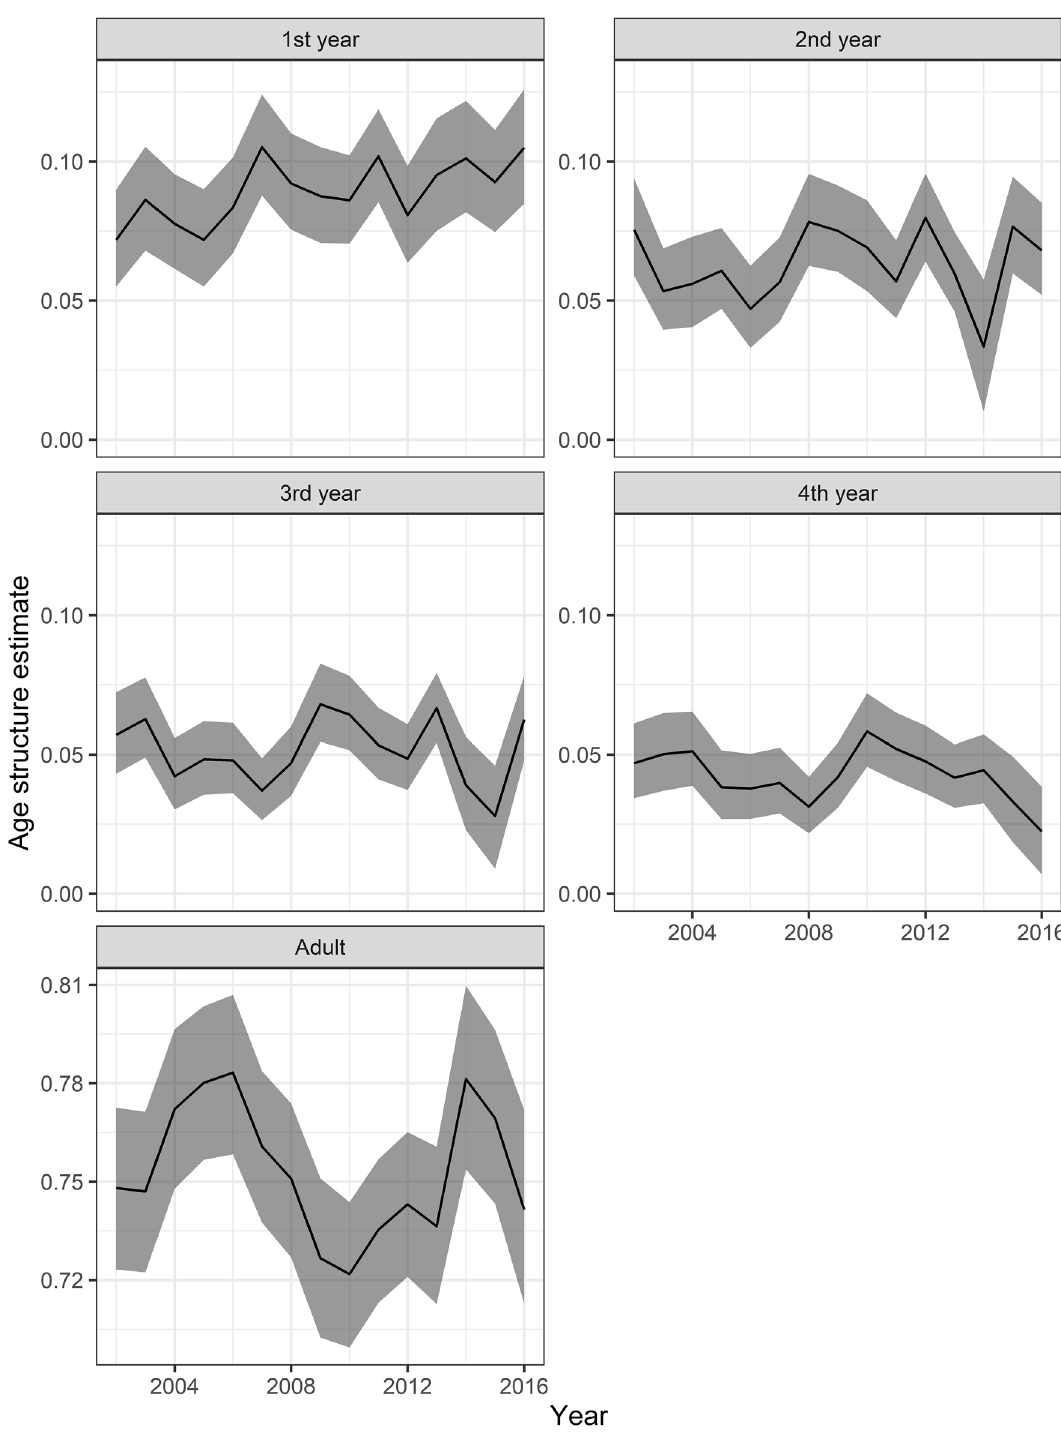
Figure 6. Age class structure estimates from IPM. Black lines indicate median estimates; gray ribbons indicate 95% CRI. Note that the y-axis is scaled differently for